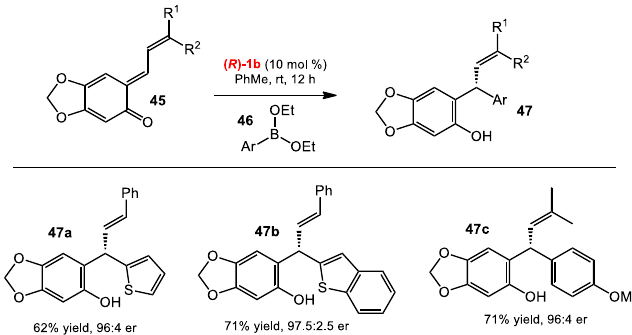
Molecules 2018 , 23 , x FOR PEER